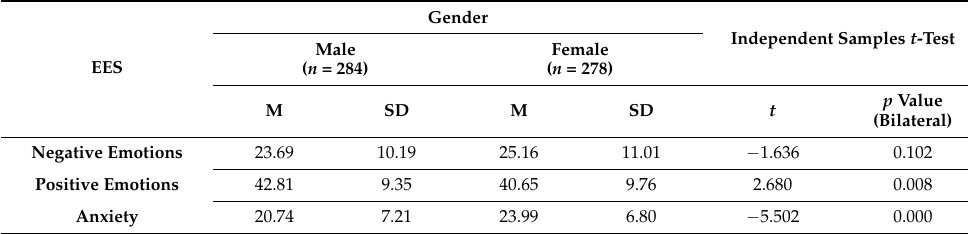
Table 5. Independent samples t -Test between EES and gender